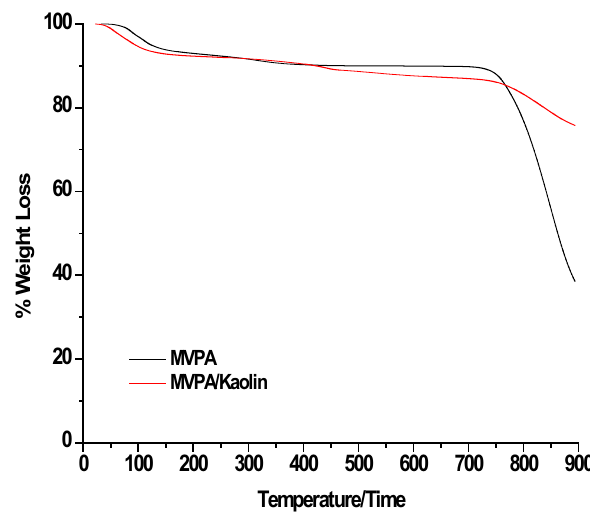
Fig. 5 Thermogravimetric analysis (TGA) curves of MVPA and MVPA/Kaolin